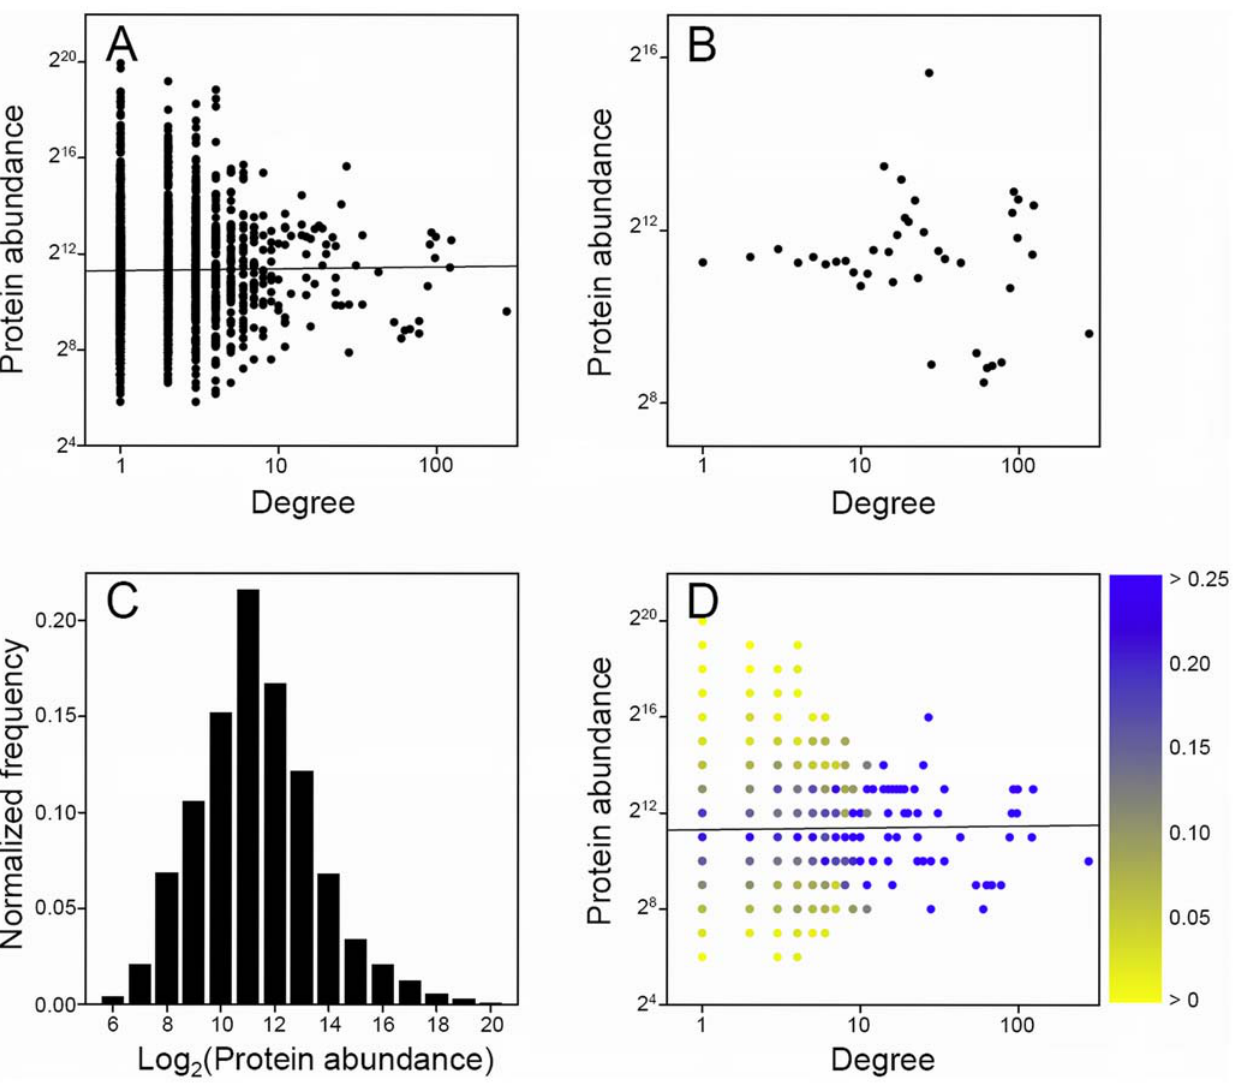
Figure 3. Relationship between protein degree and abundance in the raw yeast Y2H Ito PPI network [ 7 ] using the western blot abundance measurements of Ghaemmaghami et al. [ 42 ] . (A)–(D), see Figure 1 legend.